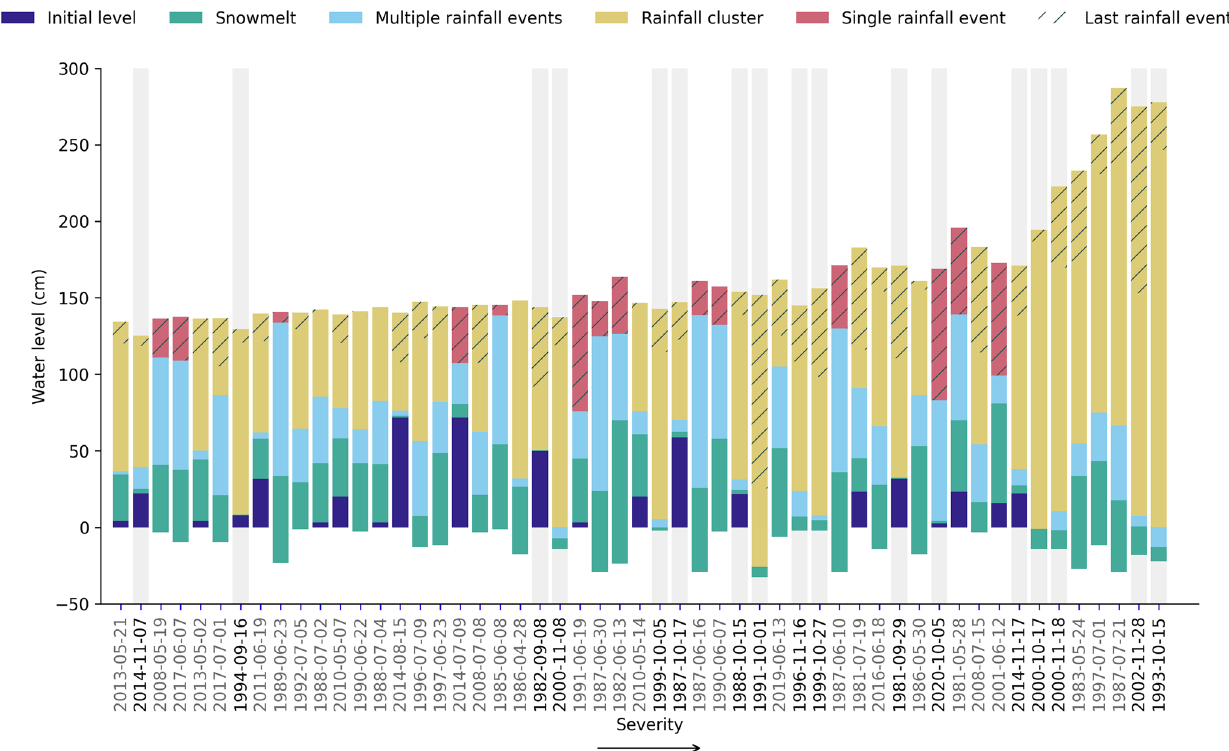
Fig. 4 Triggers of lake fl ood events. Barplot of the triggers of lake fl oods. The height of each block of a bar represents the increase of water level caused by that factor and the total height of a bar represents the difference between the water level at the fl ood peak and the minimum water level at the beginning of the season. Autumn events are indicated with a grey vertical bar. The position of the bottom of a bar with respect to the zero on the y -axis represents how much the initial water level was higher/lower than the average initial level, computed separately for spring and autumn events; if a bar starts below zero, it means that the initial level of the event was below the average one, if it is above zero, the difference between the initial level of the event and the average one is included in the initial level bar. The hatch with black lines identi fi es the contribution of the last rainfall event occurred before the date of the fl ood peak; this may be part of a rainfall cluster or an individual event. Events are in ascending order of severity, computed as the area contained between the water level during the duration of the fl ood event and the threshold level for fl